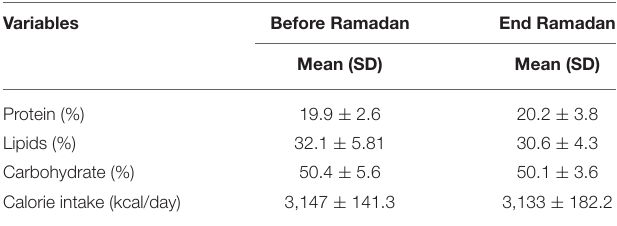
TABLE 2 | Daily nutritional intake before and at the end of the fourth week of